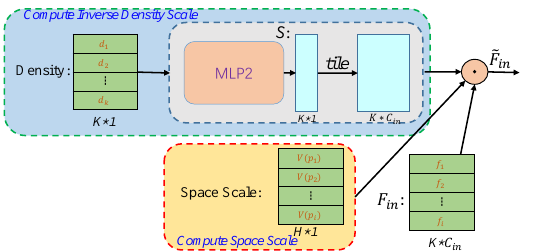
Figure 5. Part of PointConvSSN The blue area is the inverse density part of the PointConv and the yellow part is the spatial scale which is employed to estimate the influence of object occlusion on inverse